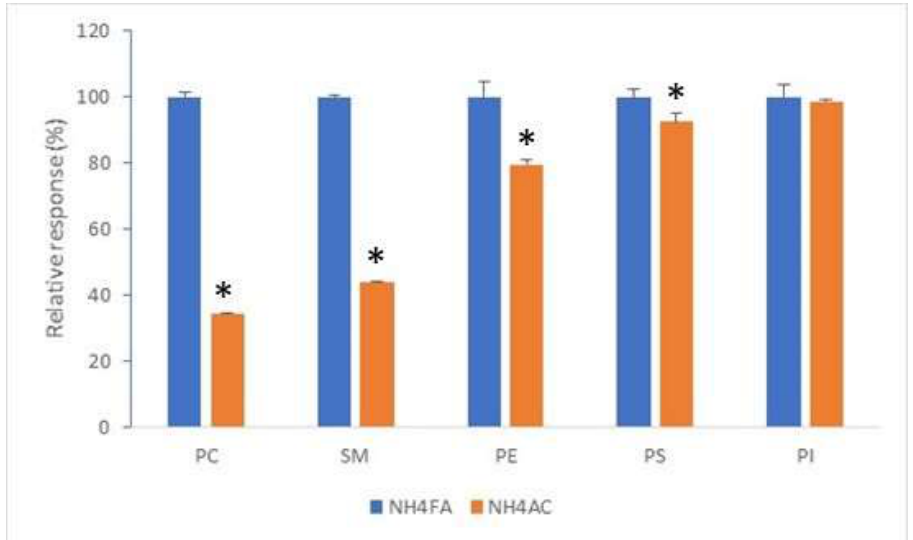
Figure 2. Relative response of phospholipid standards (Mouse Splash Lipidomix standards diluted by 32-fold) as influenced by mobile phase additives. LC separation was by the Eclipse XDB-C8 column using the multistep gradient elution. Mobile phase additive was 10 mM ammonium formate or 10 mM ammonium acetate in both binary components. Each column is the mean of 3 analyses (±SD). * Indicates significant difference by t -test ( p < 0.05).